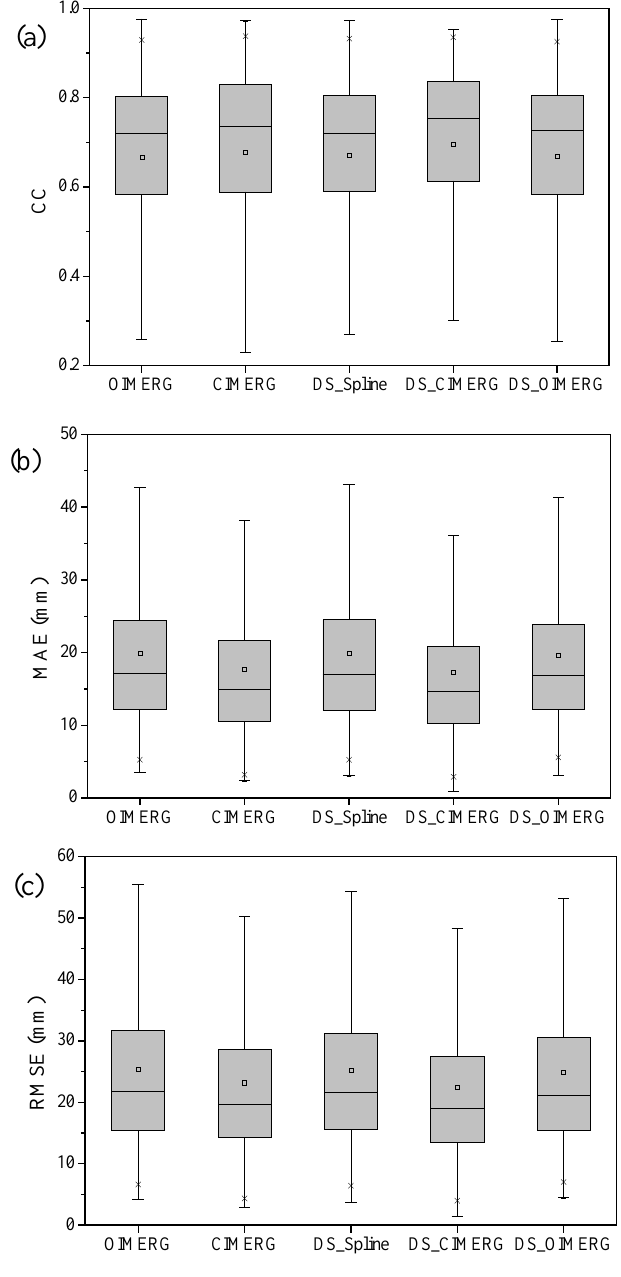
Figure 8. Boxplots of the evaluation metrics ( a , CC; b , MAE and c , RMSE) for the five precipitation datasets for the warm seasons of 2014–2018. OIMERG, original IMERG precipitation data; CIMERG, OI-corrected IMERG precipitation data; DS_Spline, obtained by using the spline interpolation method for OIMERG precipitation downscaling; DS_CIMERG, obtained via GWR downscaling with CIMERG; DS_OIMERG, obtained via GWR downscaling with OIMERG.